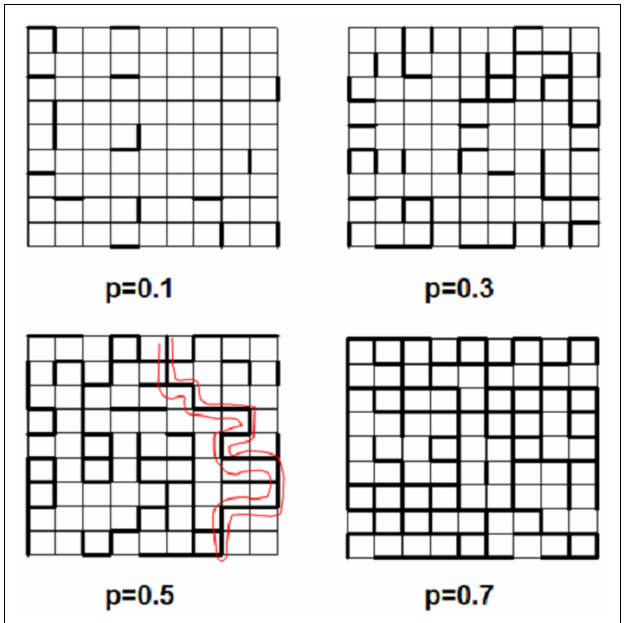
FIGURE 1 | Bond percolation on a square lattice (thin lines) for different values of the probability p . Thick line segments are occupied with probability p .The red curve marks the shortest percolating pathway at p = p c = 0.5 (with permission from Suki et al., 2011).